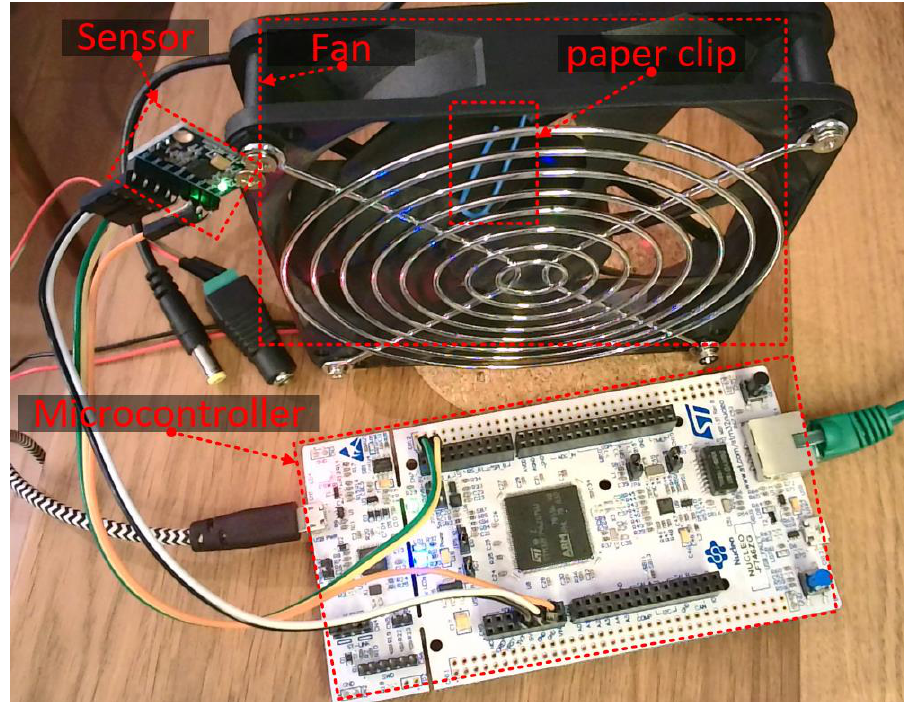
Figure 10. Demonstration system for fan fault diagnosis.